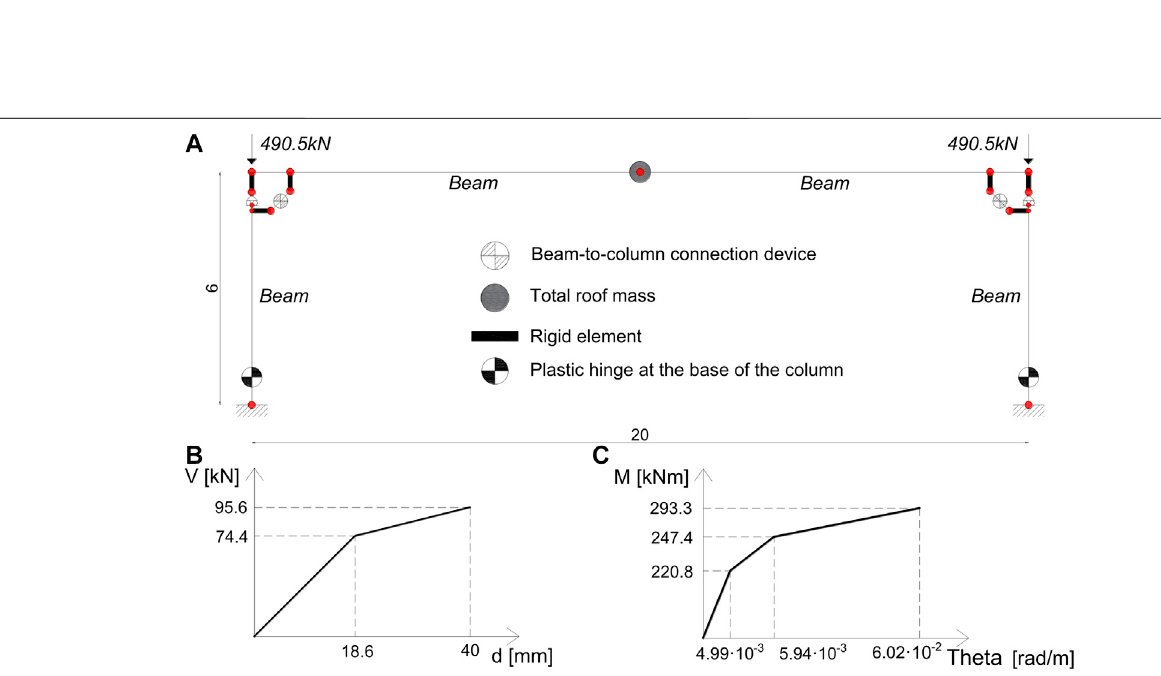
Frontiers in Built Environment |